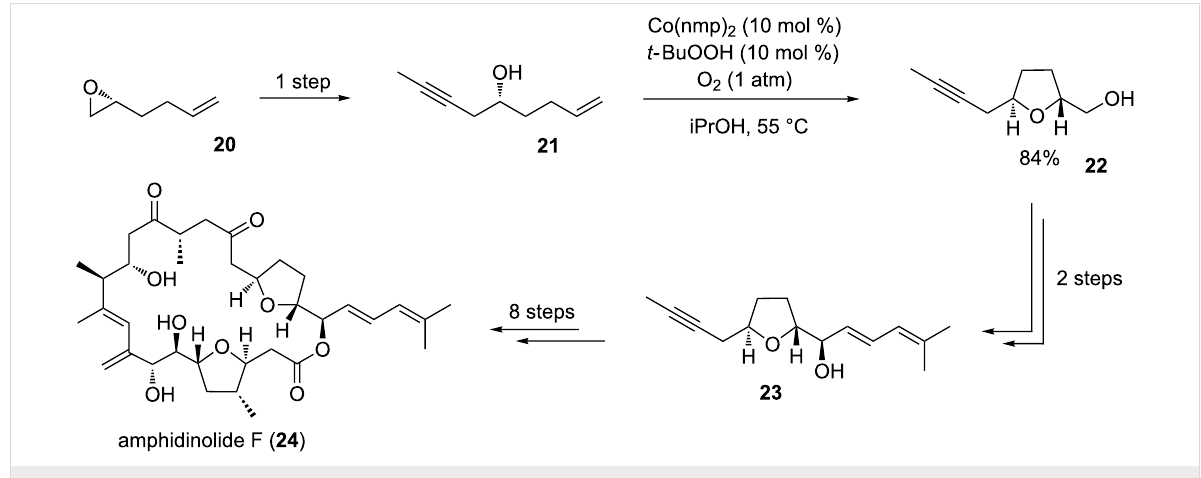
Scheme 7: Total synthesis of amphidinolide F by Fürstner and co-workers.